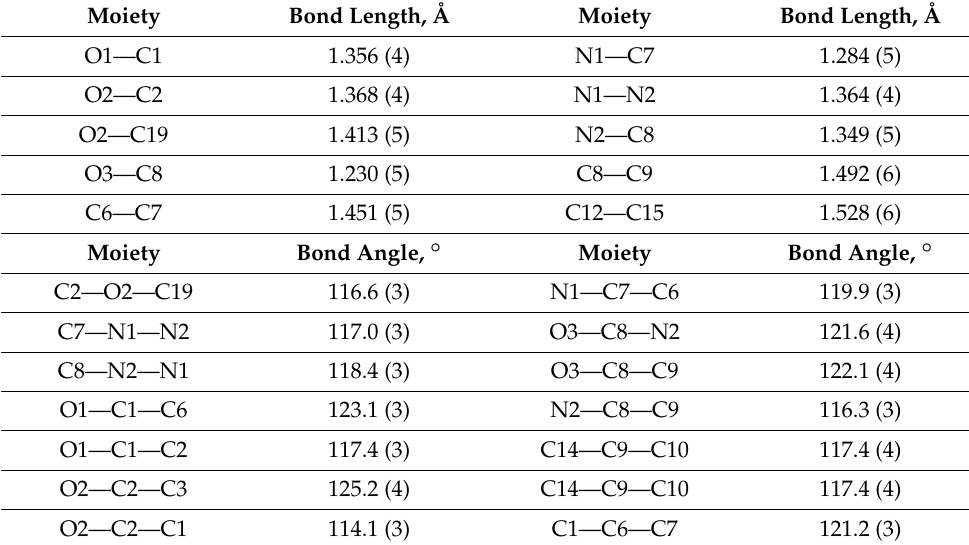
Selected bond lengths (Å) and bond angles ( ◦ ) of 4-(t-Bu)- N (cid:48) -(2-hydroxy-3- methoxybenzylidene)benzohydrazide ( 5 ).